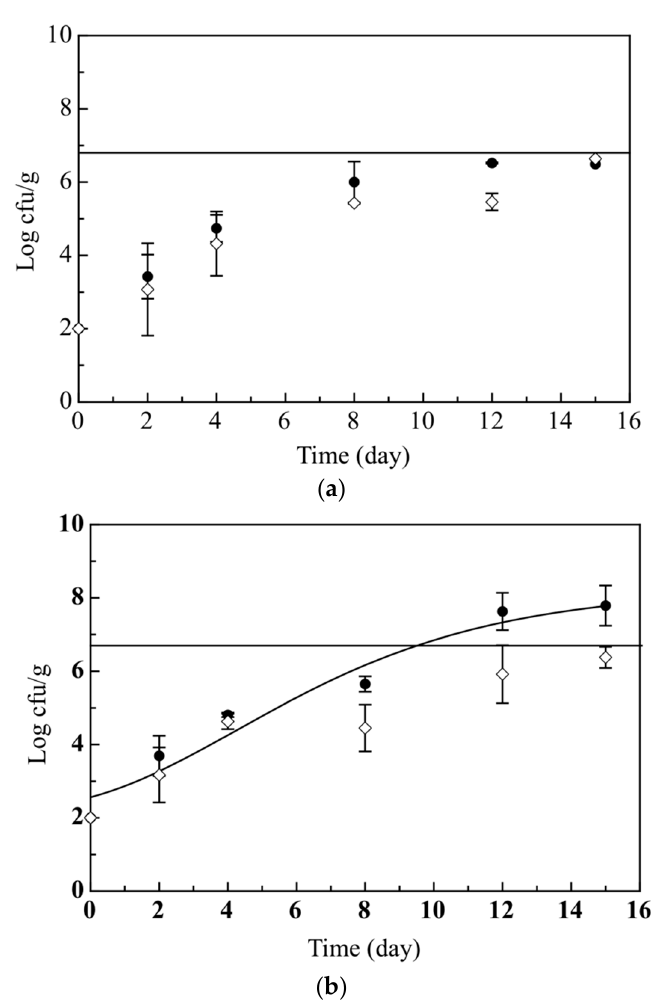
Figure 1. Evolution during 15 days of storage at 4 ℃ of total mesophilic ( a ) and psychrotrophic ( b ) bacteria in the breaded cod sticks. The curves are the best fitting of the experimental data. ( • ) Control breaded cod sticks without olive paste (Ctrl) ( ◊ ) Active breaded cod sticks with olive paste (Active).